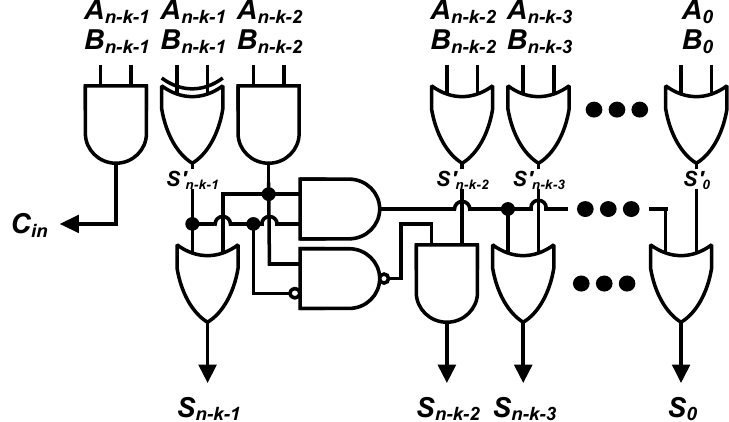
Figure 5. Architecture of approximate part of proposed adder, i.e., hybrid error reduction LOA (HERLOA).